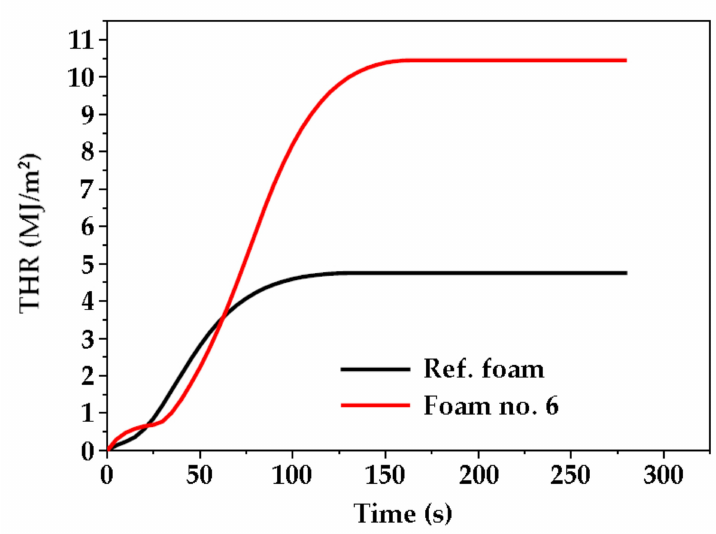
Figure 8. Total heat released (THR) of the reference foam (Ref.) and foam based on MSA- and PLA-polyol (no. 6) as function of